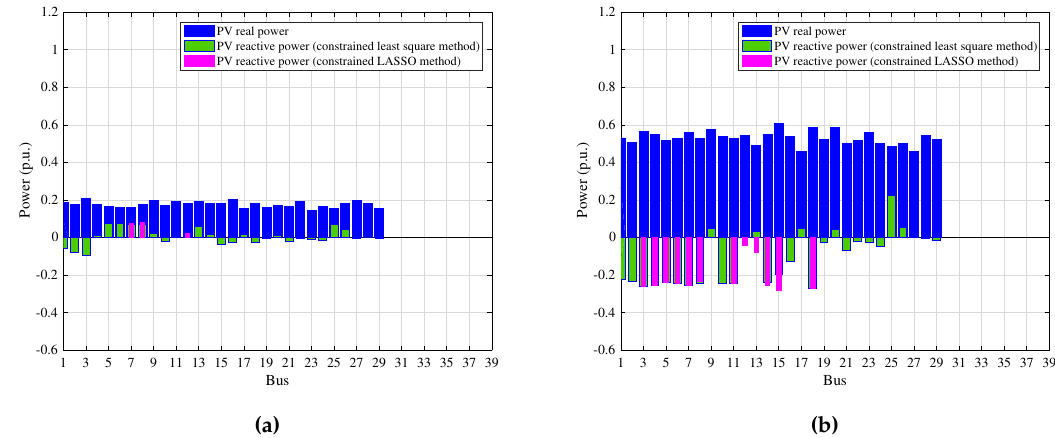
Figure 3. Examples of PV power generation at consumer buses with uniform distribution of PV generators at consumer buses of the 39-bus power system. Net real power generation of PV is 10% and 30% of the net real power demand at consumer buses respectively, and the corresponding reactive power set point of PV inverters computed with the constrained least-square method and constrained LASSO method. ( a ) Net PV real power generation is 10% of the net real power demand at consumer buses; ( b ) Net PV real power generation is 30% of the net real power demand at consumer